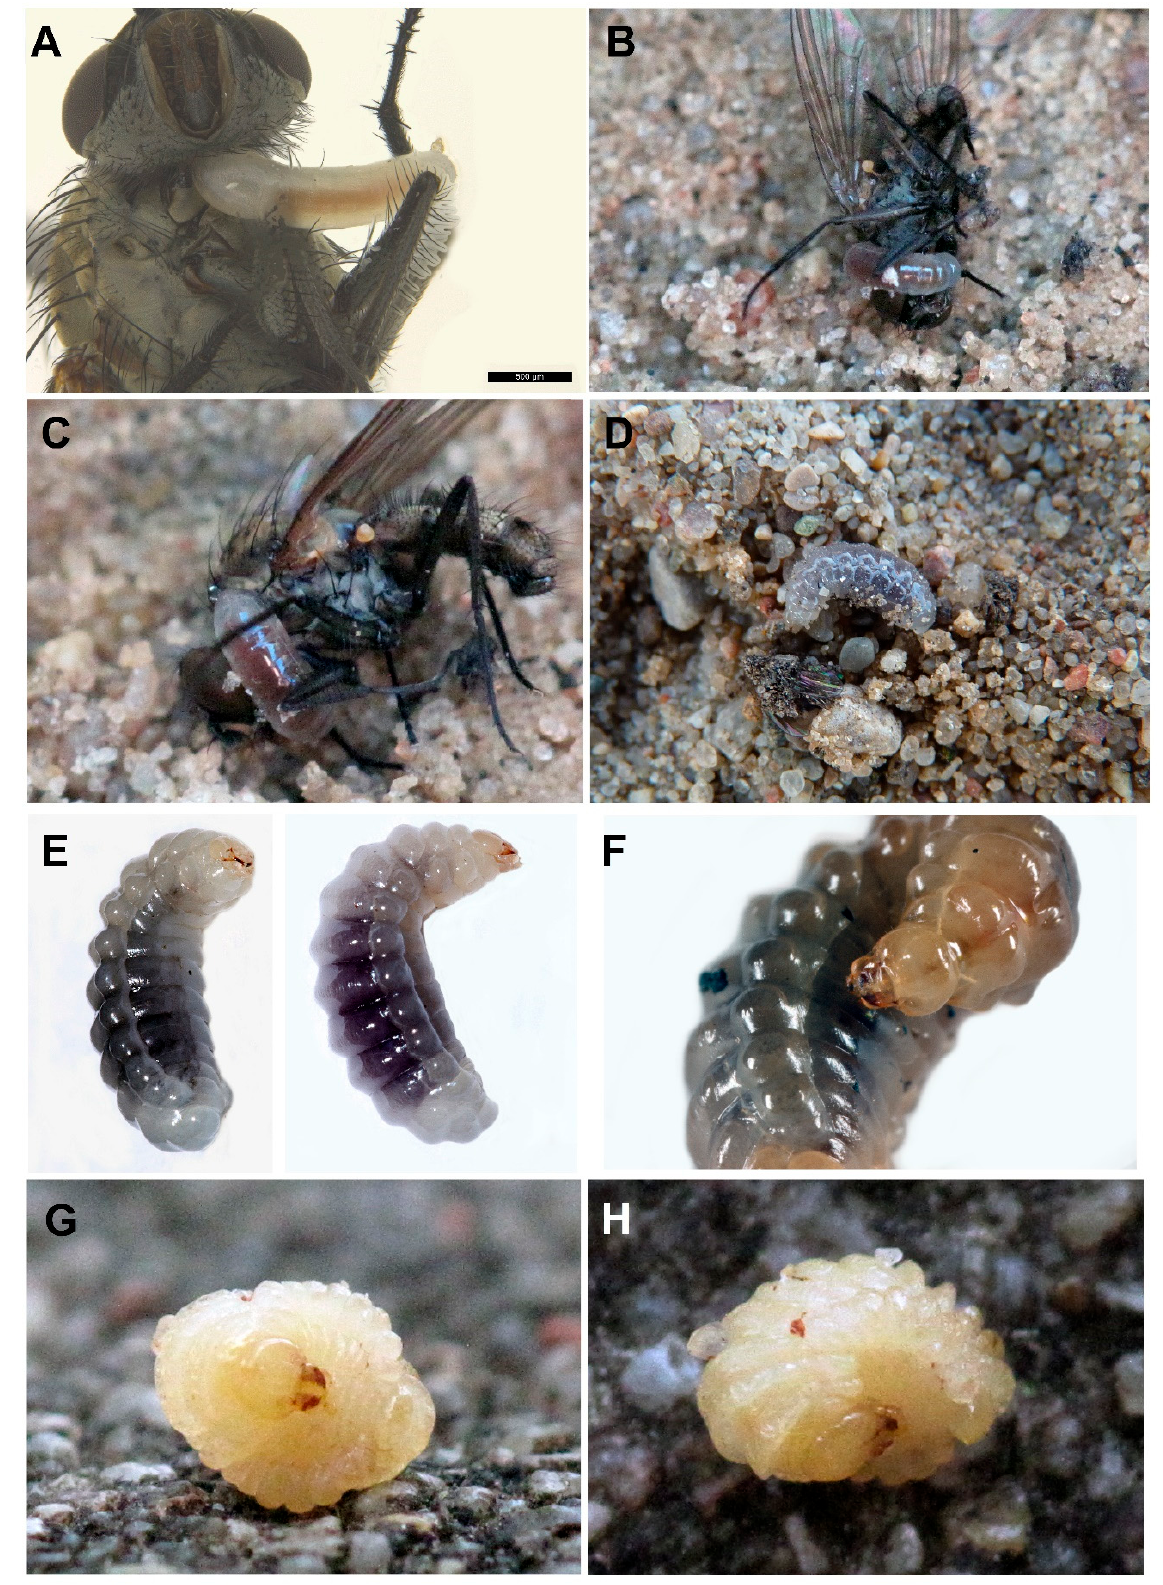
Figure 3. Developmental stages of Oxybelus variegatus . ( A ) Egg; ( B – H ) larva.